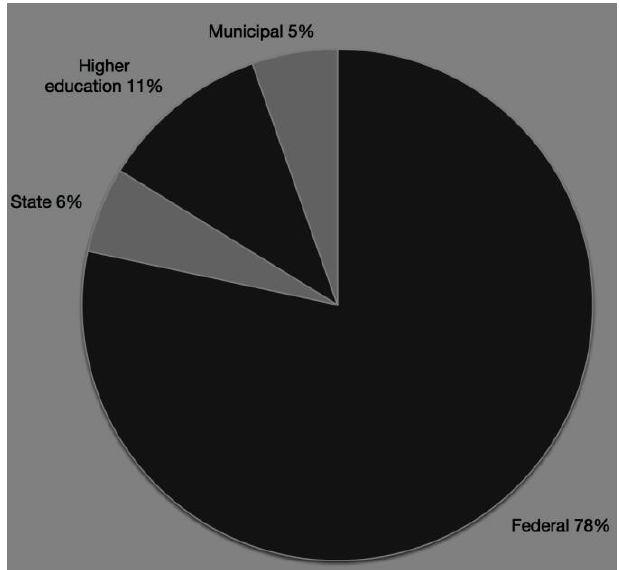
Figure 3. Main entity representing the